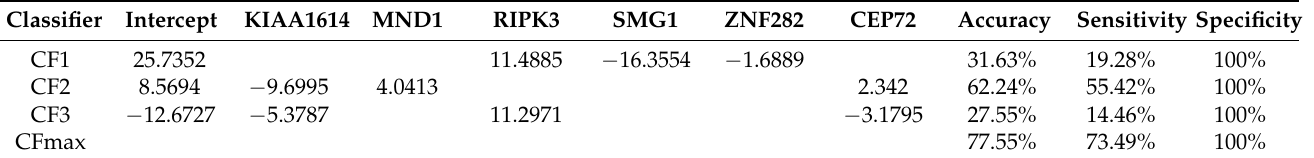
Table 12. GSE166190: Characteristics of the top-performing six-gene classifier. CF1, CF2, CF3 are the first, second and third individual classifiers for data of COVID-19 patients vs. healthy controls. The data were natural logarithm-transformed as ln(KIAA1614/10+1), ln(MND1+1),